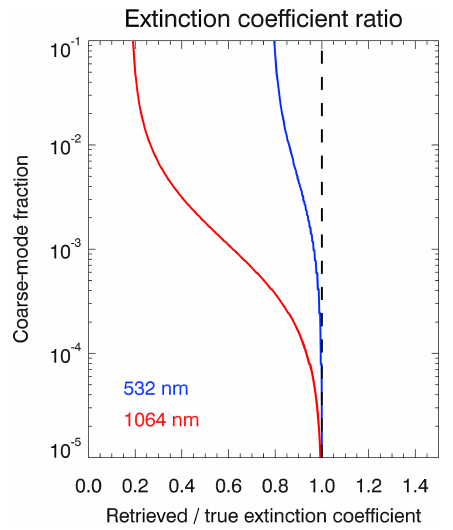
Figure 9. Shown is the ratio of the extinction coefficient retrieved from the simulated lidar measurements and the true extinction co- efficient as a function of the coarse-mode fraction of the bimodal particle size distribution and for the two wavelengths considered. For decreasing coarse-mode fractions, the ratio asymptotically ap- proaches 1 as expected.